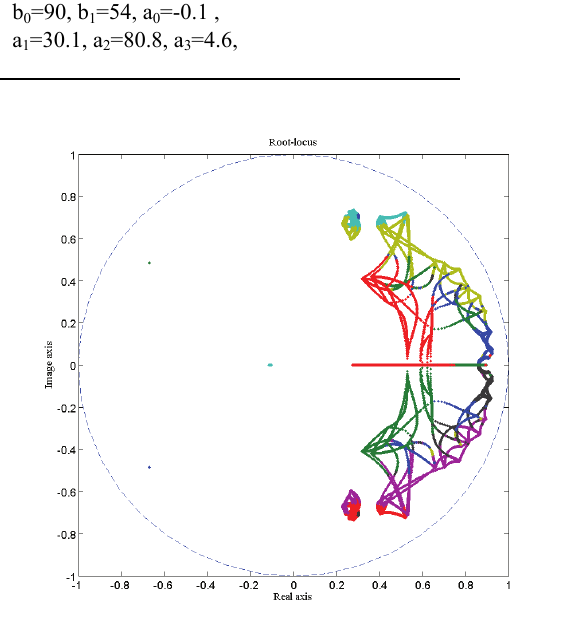
Fig.6. Roots distribution of the discrete system with the 32 subsets of interval plant family